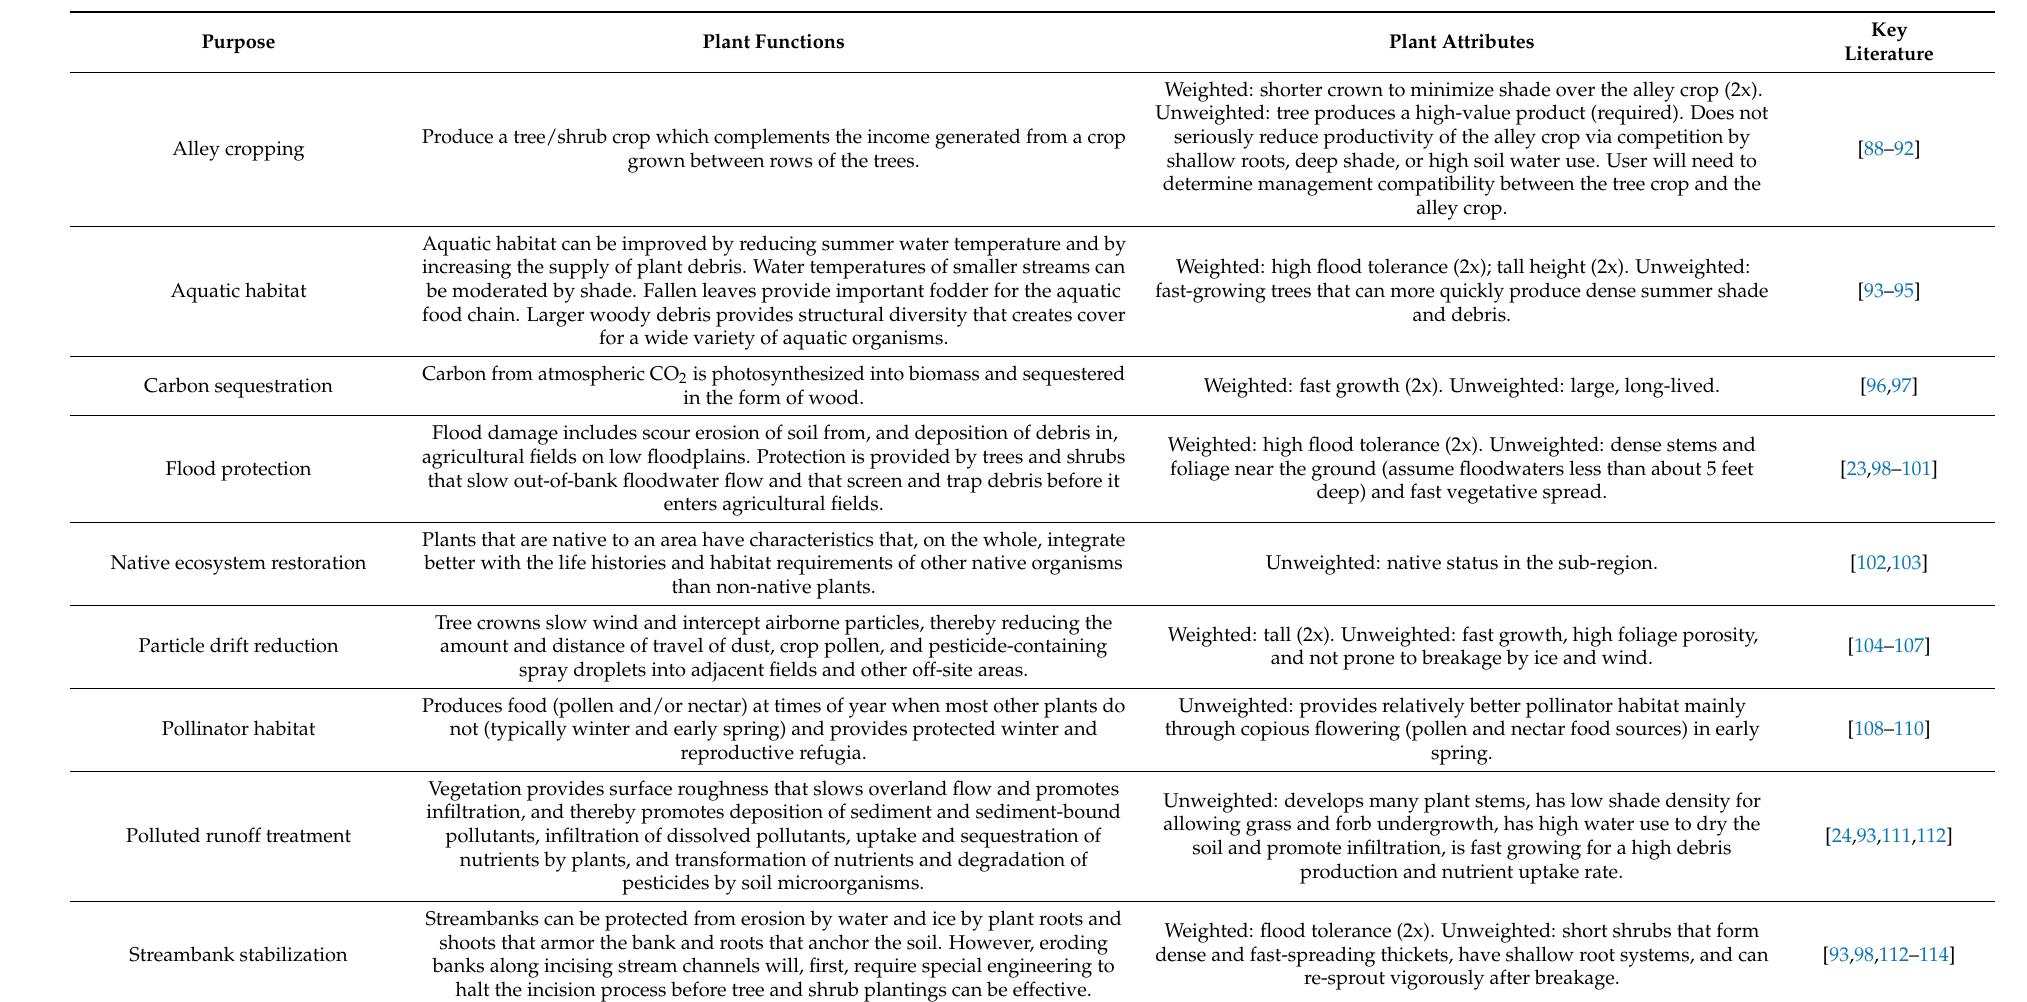
Table 1. Purposes rated in Tree Advisor with their associated plant functions and attributes based on the scientific